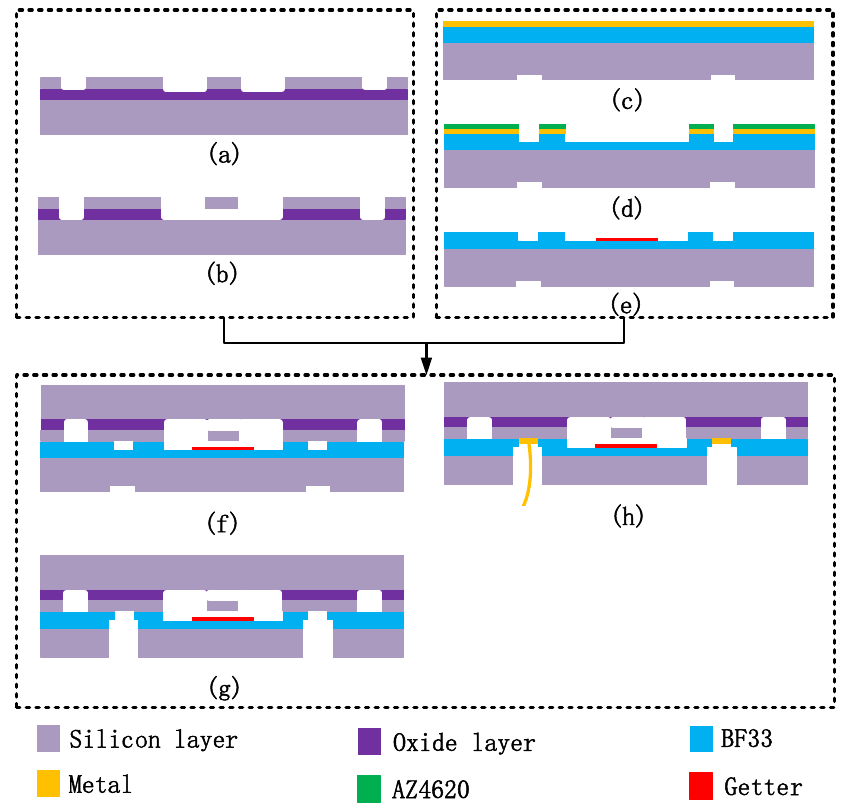
Figure 7. Main steps of the microfabrication process.